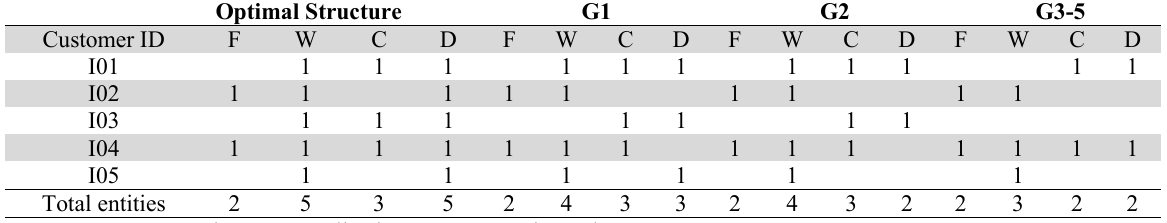
The output of model in optimal conditions Optimal Structure G1 G2 G3-5 Customer ID